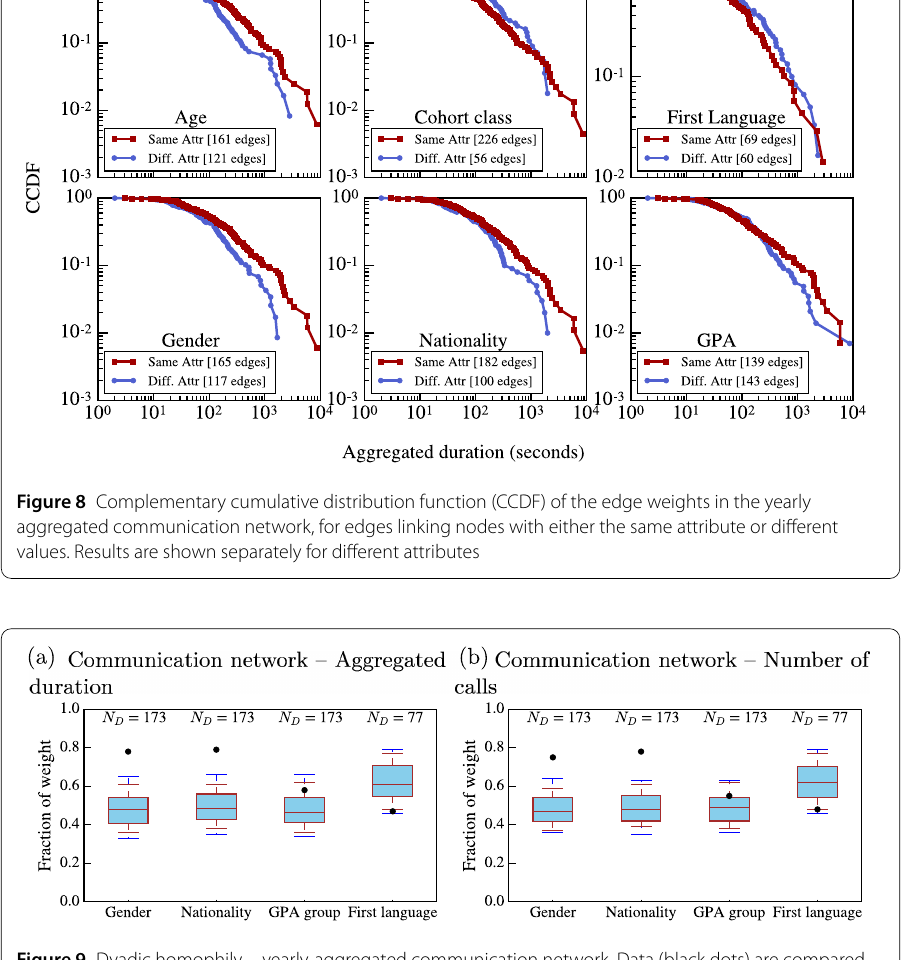
Figure 9 Dyadic homophily—yearly-aggregated communication network. Data (black dots) are compared with the distribution (boxplots) obtained for a null model in which attributes are reshuffled among nodes. N D gives the number of dyads on which the measure is performed. Boxplot: Whiskers—5th, 10th and 90th, 95th percentiles; box—25th and 75th